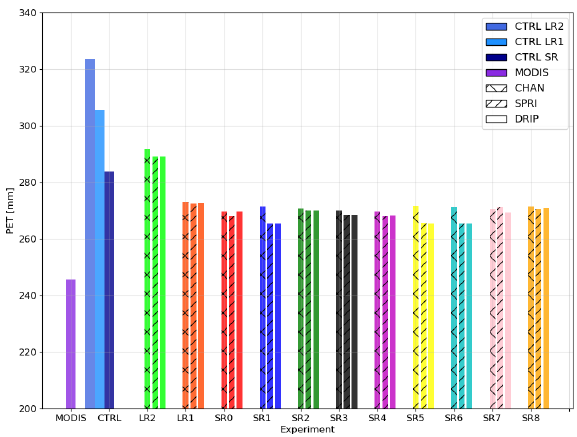
Figure 8. Monthly potential evapotranspiration accumulated for the irrigated area of the Po Valley (Fig.